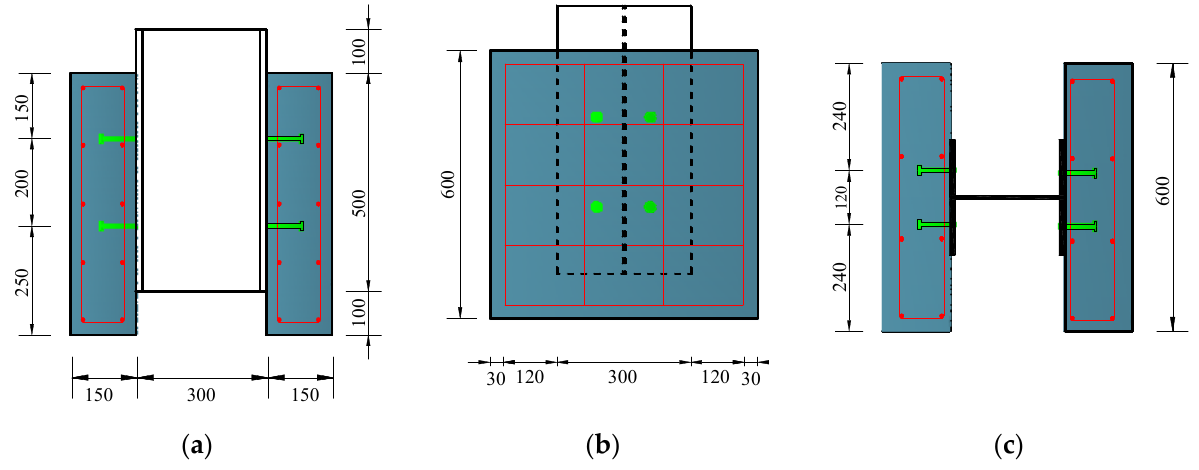
Figure 1. Geometry of push ‐ out specimens: ( a ) front view; ( b ) side view; ( c ) plan view (unit: mm).